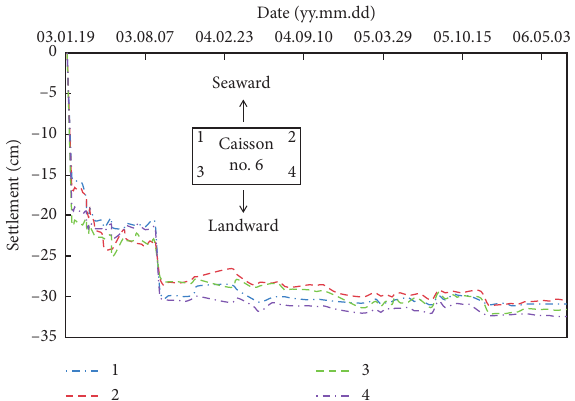
Figure 20: Time history of caisson’s settlement at seaward (numbered as 1 and 2) and landward sides (numbered as 3 and 4) of caisson #6.